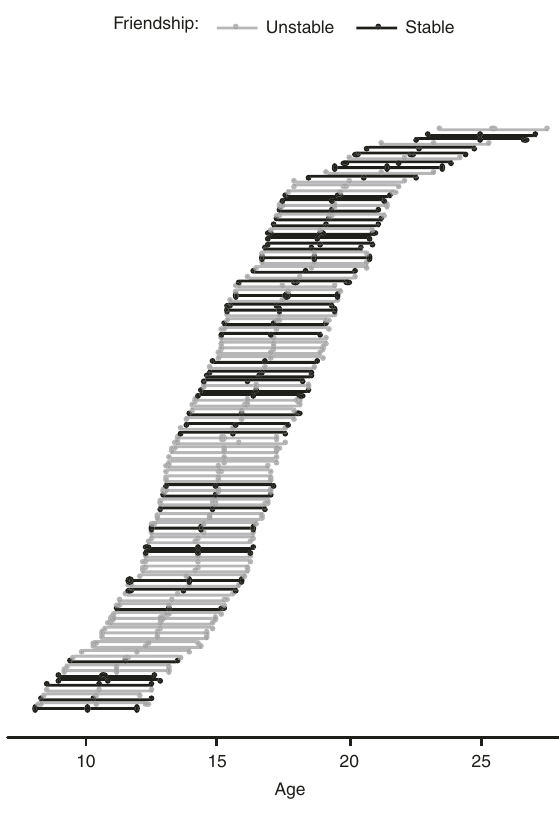
Fig. 4 Display of age of each participant at three time points of data collection. Participants with stable friendships are indicated in black ( n = 48) and with unstable friendships ( n = 75) in gray. Dots represent a data point and connected dots one